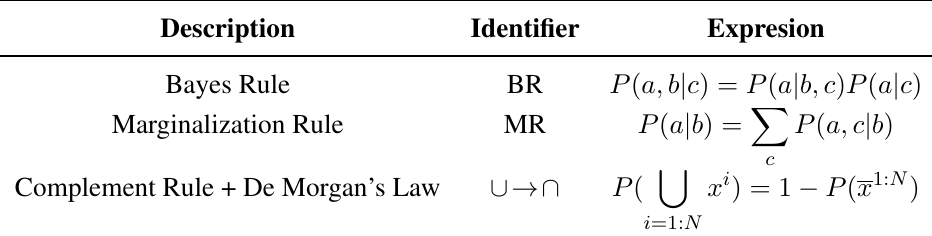
Table A1. Basic probability